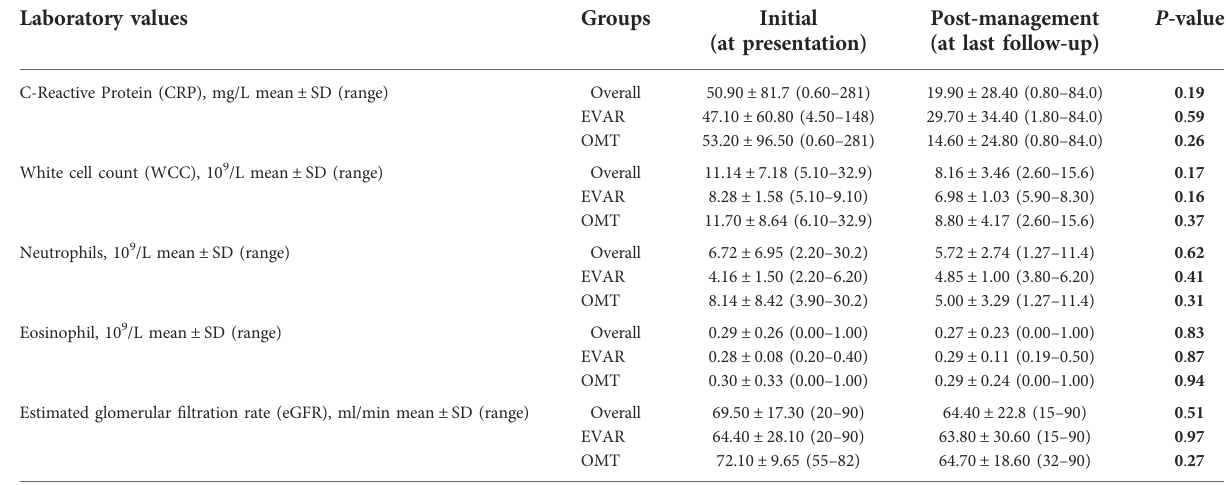
TABLE 2 Laboratory and biochemical parameters of the retroperitoneal fi brosis patients at the initial diagnosis, post optical medical treatment (OMT), and post endovascular aneurysm repair (EVAR). Laboratory values